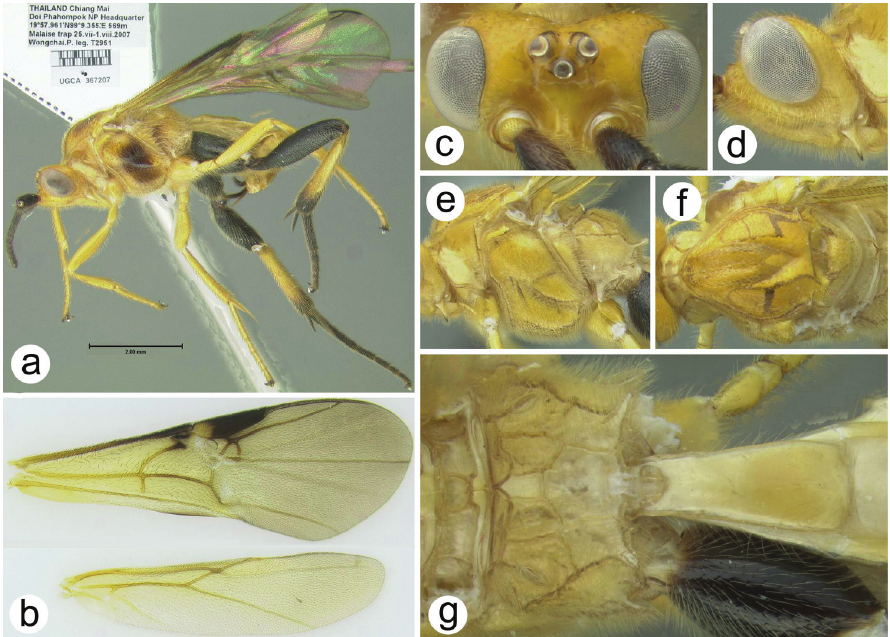
Figure 4. Zelodia charoeni sp.n. a lateral habitus b wings c dorsal head d lateral head e lateral mesosoma f dorsal mesosoma g dorsal propodeum and